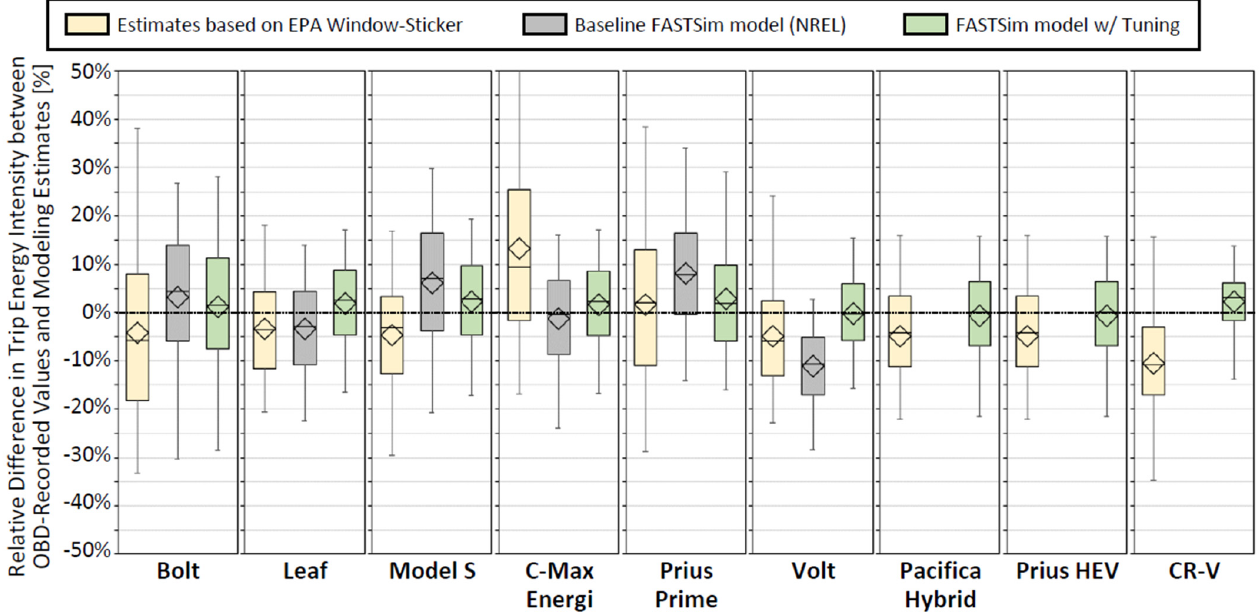
Figure 3. Validity assessment for trip energy intensity estimation models for whole groups of vehicle samples.